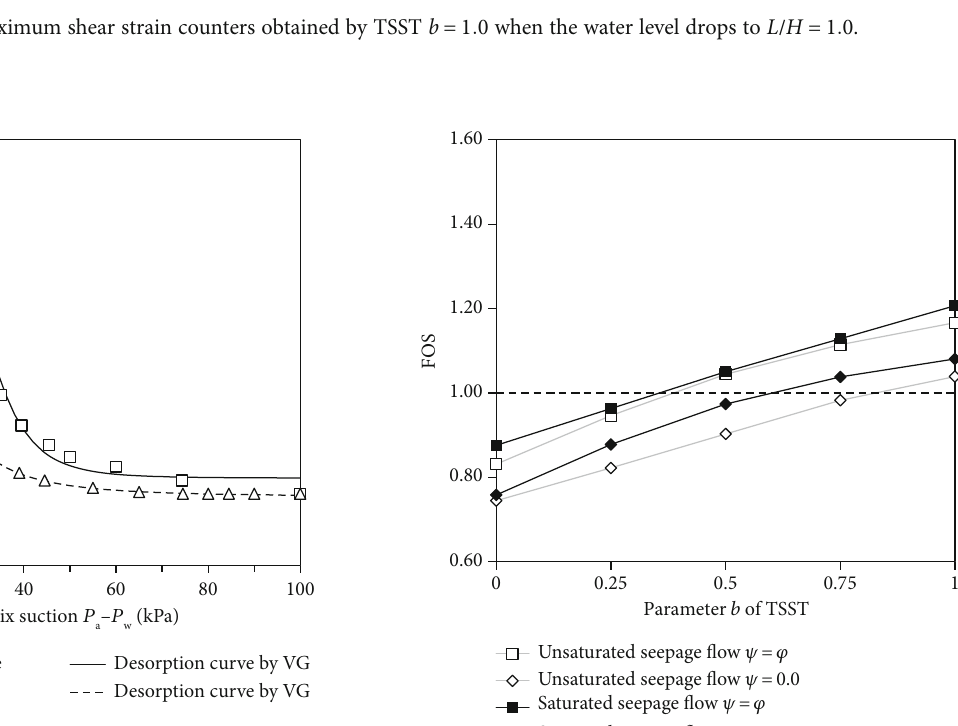
Figure 3: Soil-water characteristic curves.